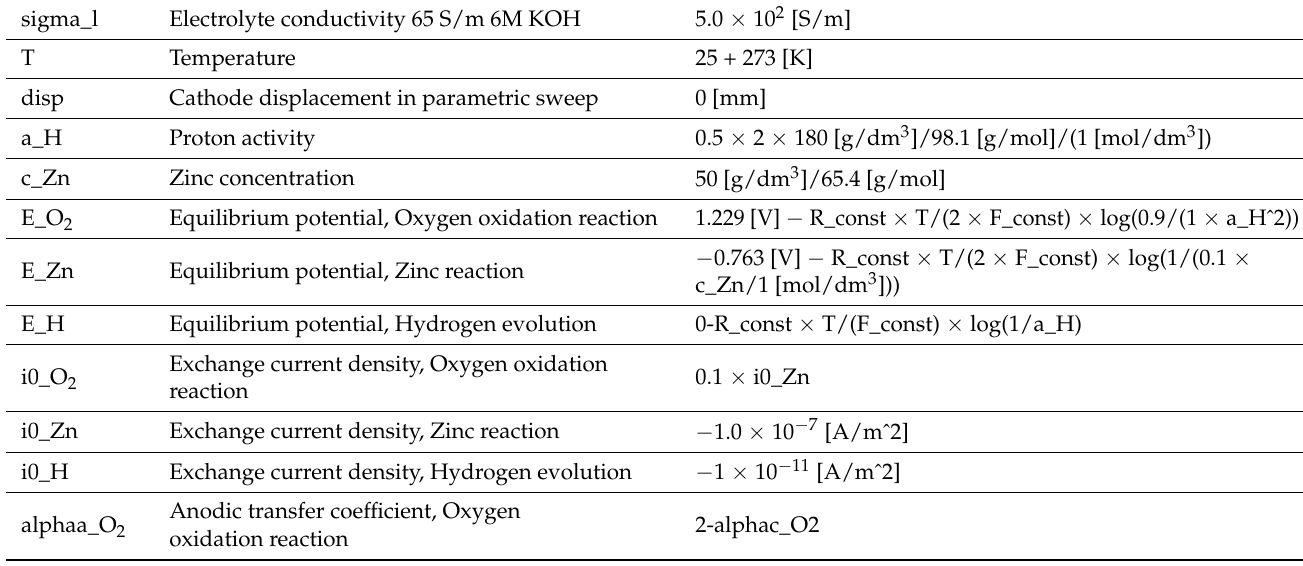
Table 3. Parameter values of Cells 1 and 2 for linear scanning voltammetry